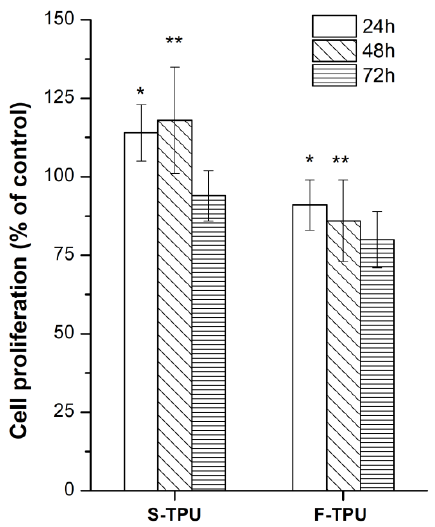
Figure 7. The effect of S-TPU and extruded F-TPU extracts on the in vitro growth of mouse embryonic fibroblast NIH 3T3 cells measured using MTT assay. Cell proliferation is represented as a percentage of control cell growth in cultures containing no S-TPU or extruded S-TPU filament extracts. Results are a mean ± SD of two separate experiments wherein each treatment condition was repeated in two wells. * p < 0.05; ** p < 0.001 vs. control.